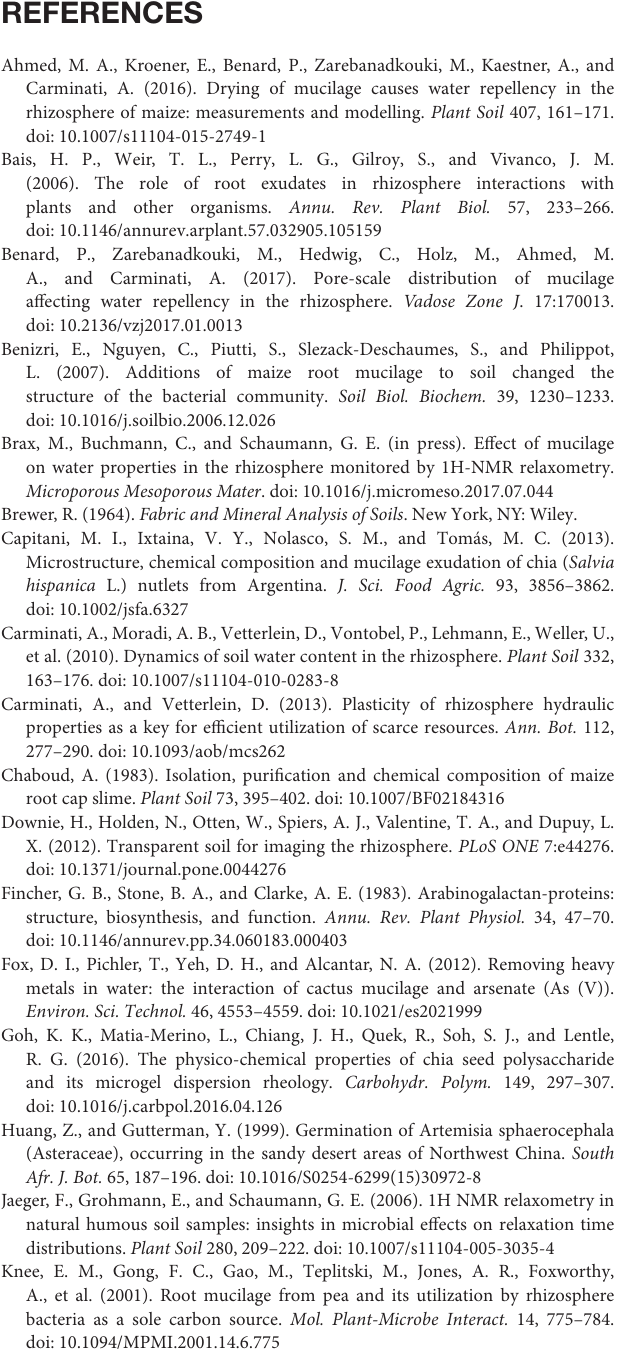
(black), and (c) pore-size distribution of the liquid phase, warmer colors indicate bigger pore-sizes and cluster bigger than 0.3 are colored white. Figure S3 | Histograms of local radius of the liquid phase in Nafion loose and sand loose at t = 325h. Histogram bins are 20 µ m, smallest detectable pore size is 40 µ m. The red shaded area indicates the range of soil pores, the blue shaded area indicates the range covered by chia